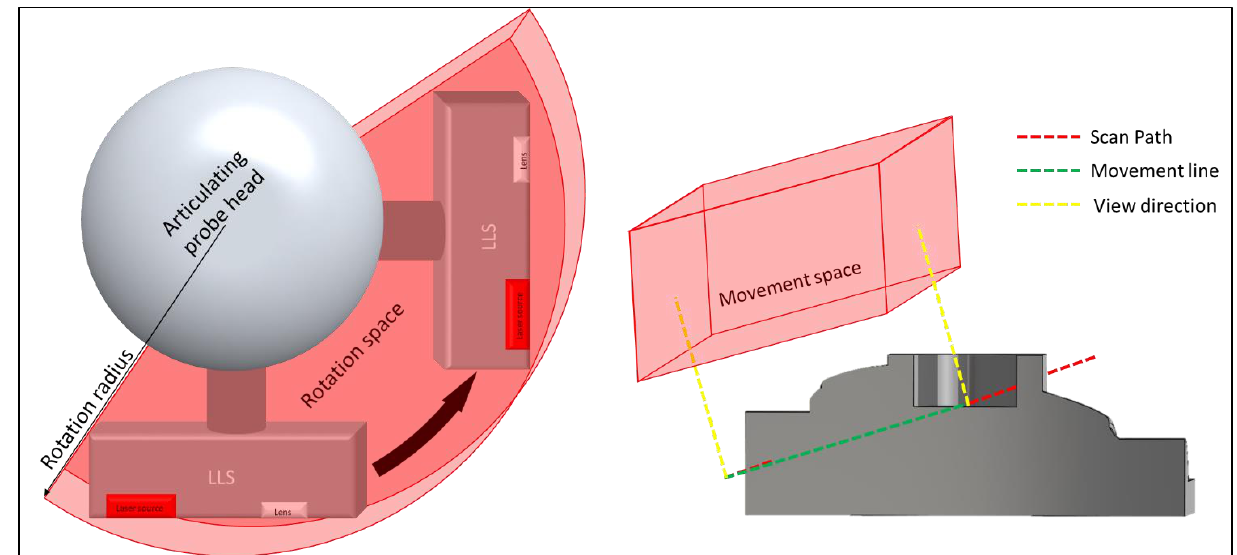
Figure 8. The rotation space ( left ) and the movement space ( right ) of the LLS.